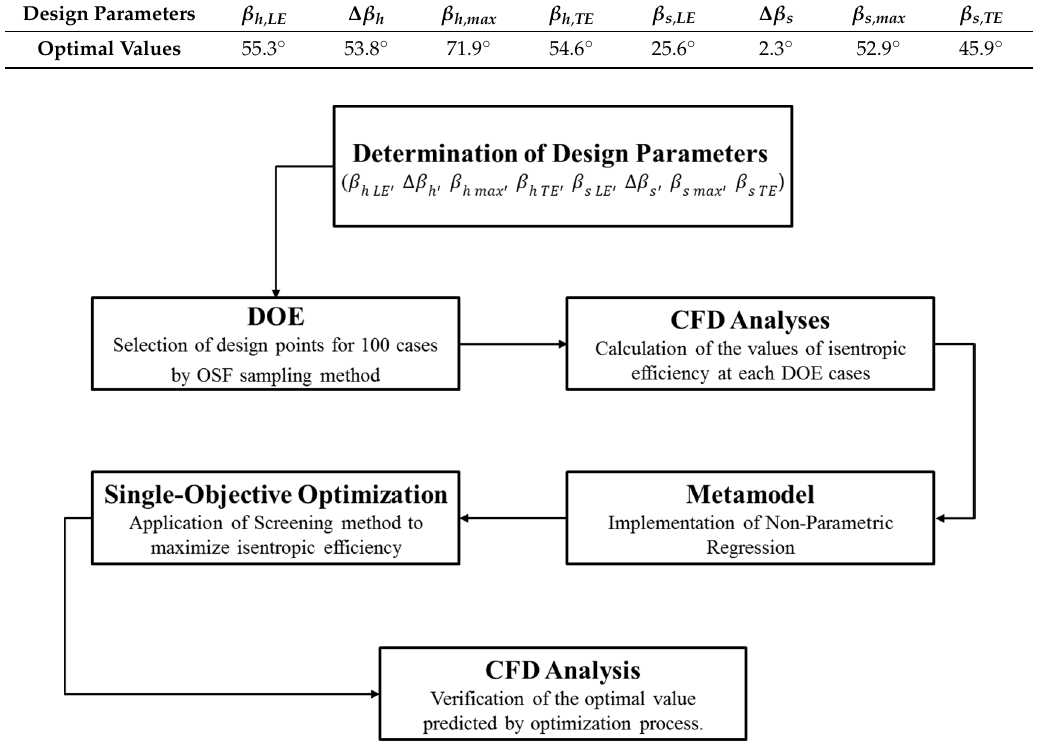
Figure 10. Single-objective optimization procedure for the beta distribution.